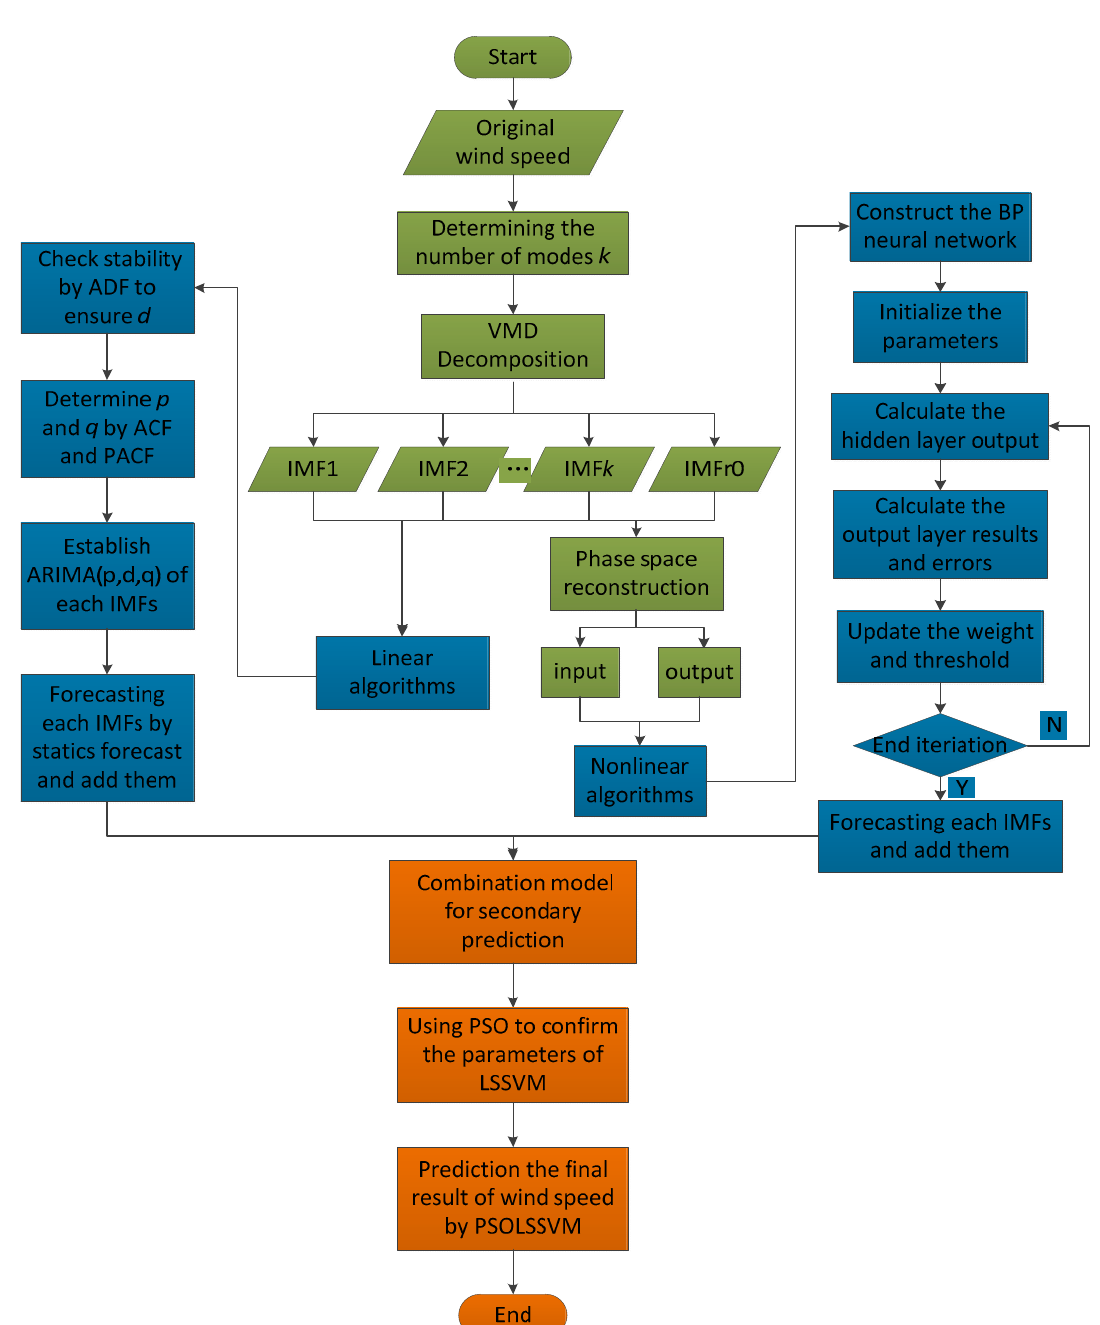
Figure 2. Flowchart of the model proposed in this paper.